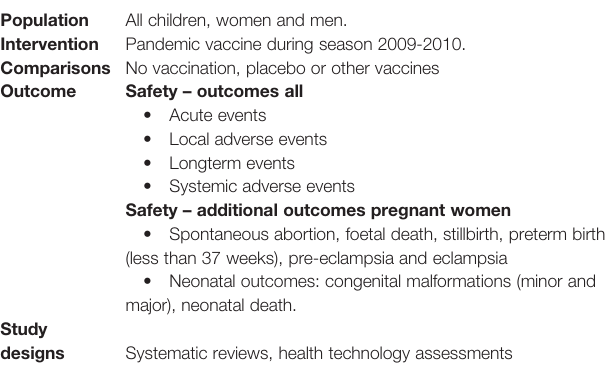
TABLE 1 | Review inclusion criteria (PICO). Population All children, women and men. Intervention Outcome